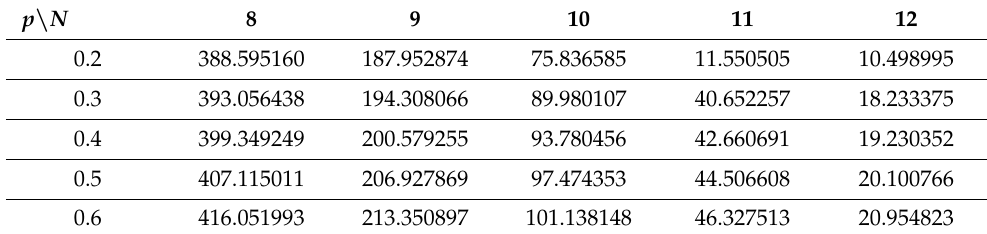
Table 6. Effect of p vs. N on the waiting time of a customer in the orbit. p \